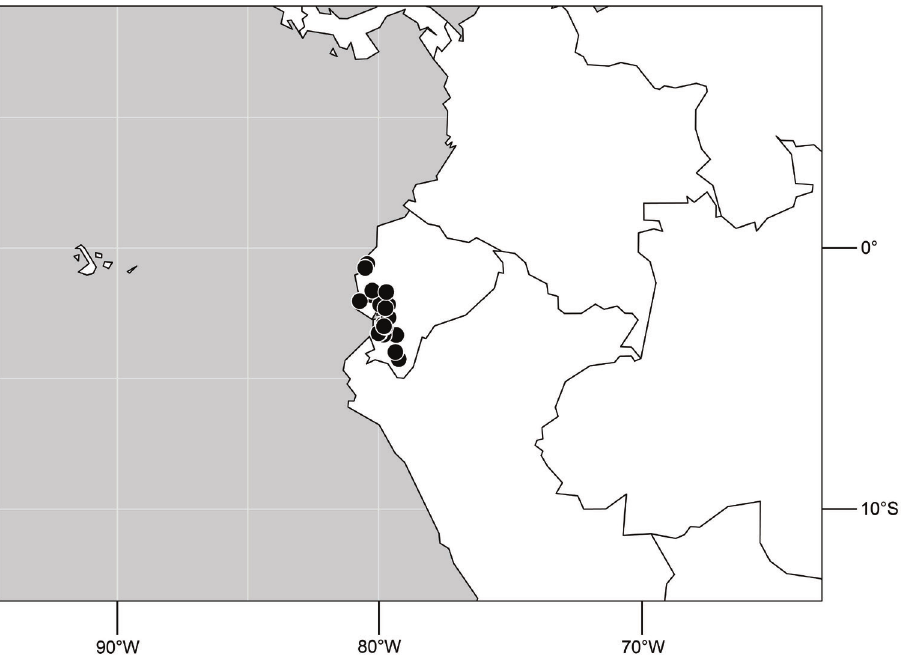
Figure 136. Distribution of Hydrochasma andeum sp.